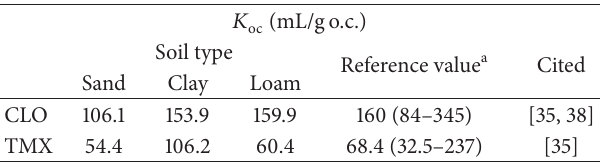
a Mean values; ranges are shown in